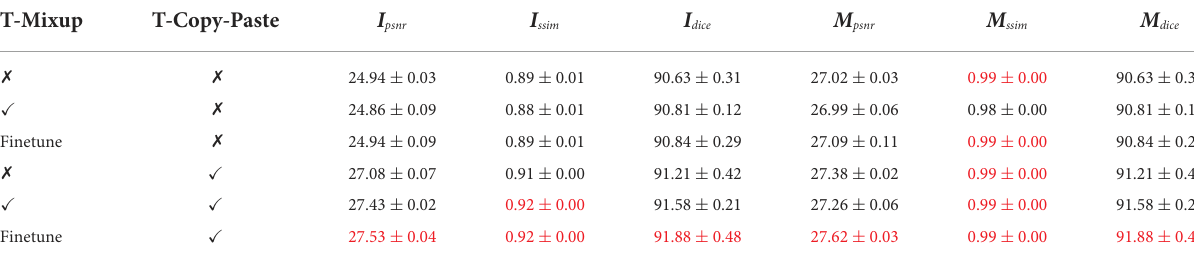
TABLE 6 Ablation study of data augmentation.